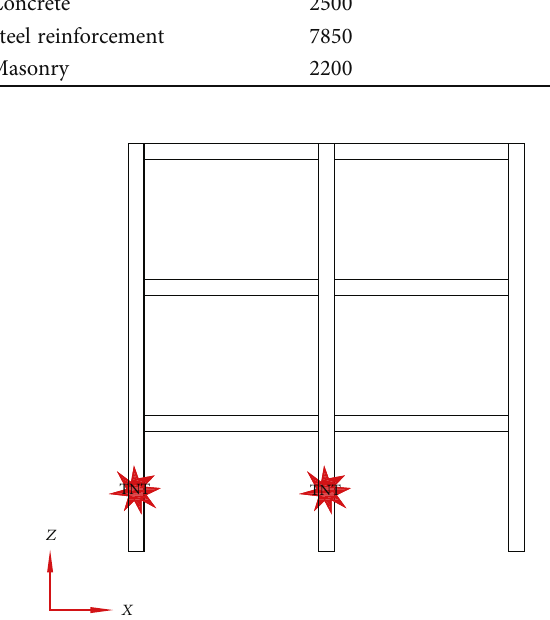
Figure 3: The position of explosives in X-Z plane.